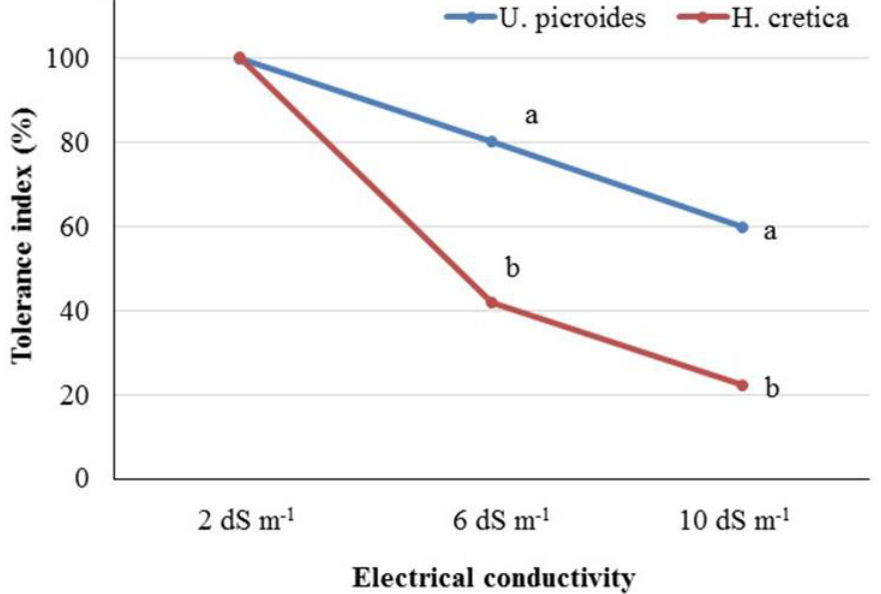
Figure 2. Salinity tolerance index of Urospermus picroides and Hedypnois cretica plants grown under different EC levels (2, 6, and 10 dS m − 1 ) in nutrient solution. Different letters indicate statistically significant differences in the salinity tolerance index of the plant species (in each EC level separately) according to the t -test at p < 0.05 .